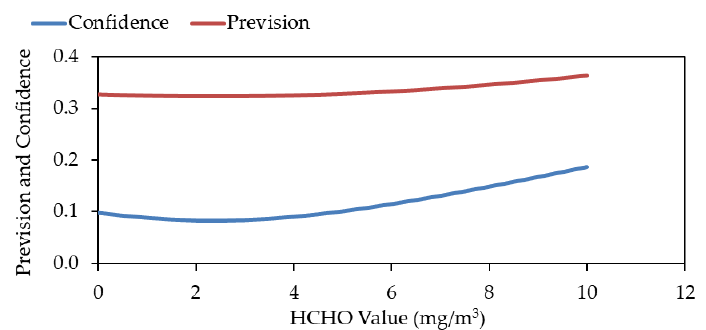
analysis from Lab. RSE.